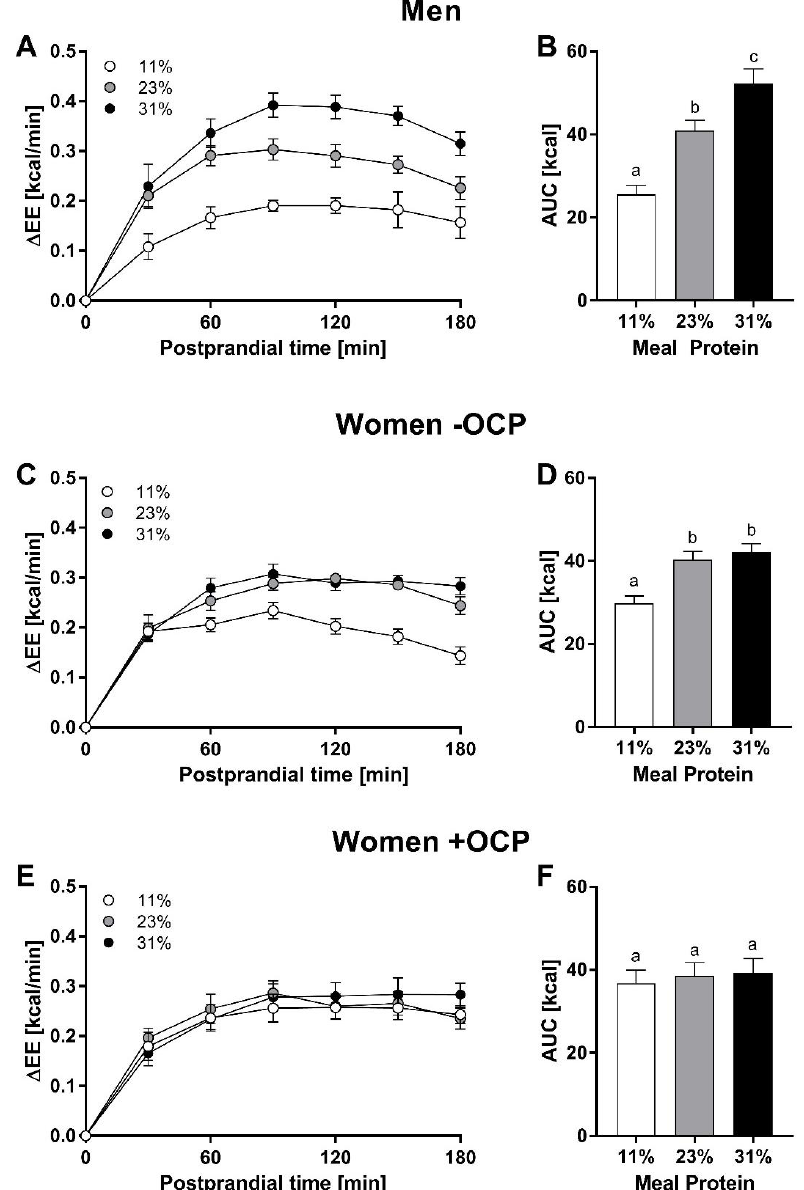
Figure 1. Change in resting EE ( ∆ EE) following ingestion of each of three isocaloric meals containing di ff erent protein levels (11, 23, and 31% total energy as protein). Values are mean ± SEM. Left panels ( A , C , E ) indicate 30 min means; right panels ( B , D , F ) indicate the area-under-curve (AUC) over 180 min. Bars not sharing superscript (i.e., a,b) are significantly di ff erent ( p < 0.05) from one another by repeated measures ANOVA. OCP: oral contraceptive